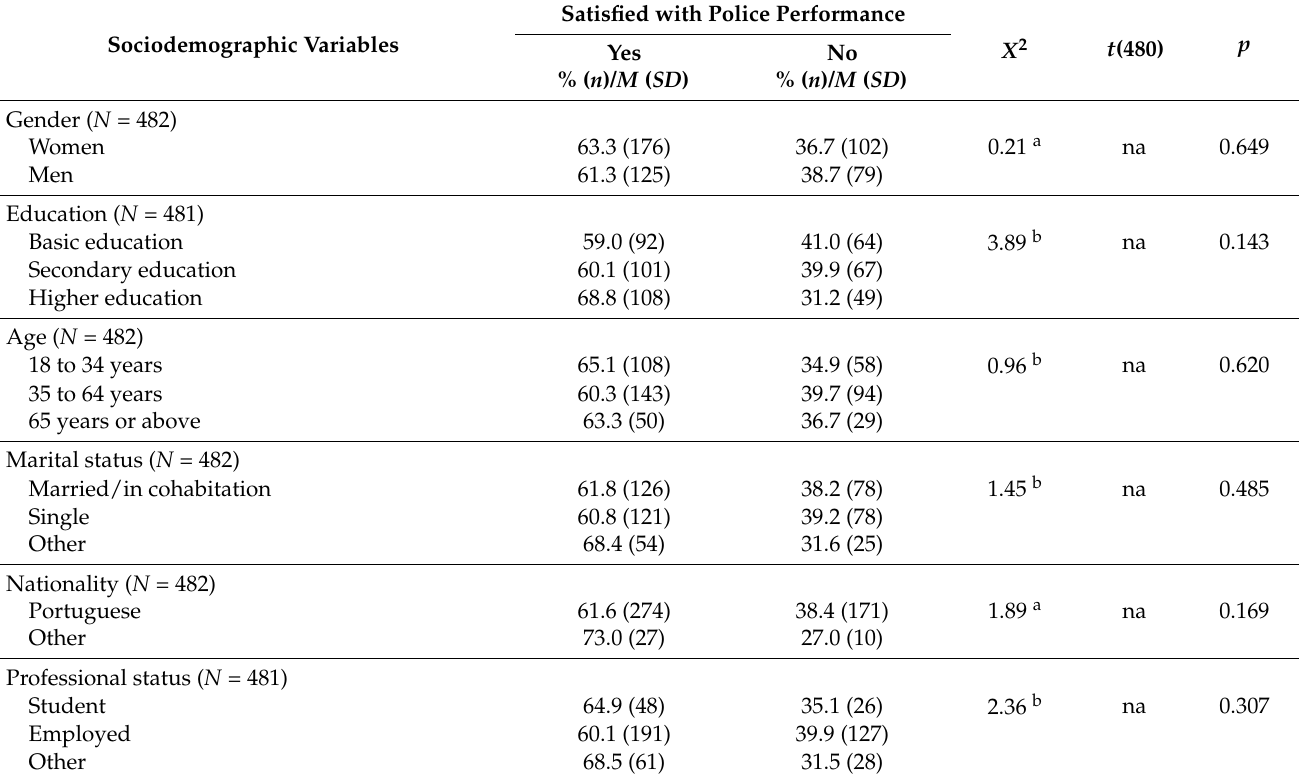
Table 2. Frequencies and inferential tests for police performance satisfaction by sociodemographic, victimisation, criminal, environmental, social control, and community